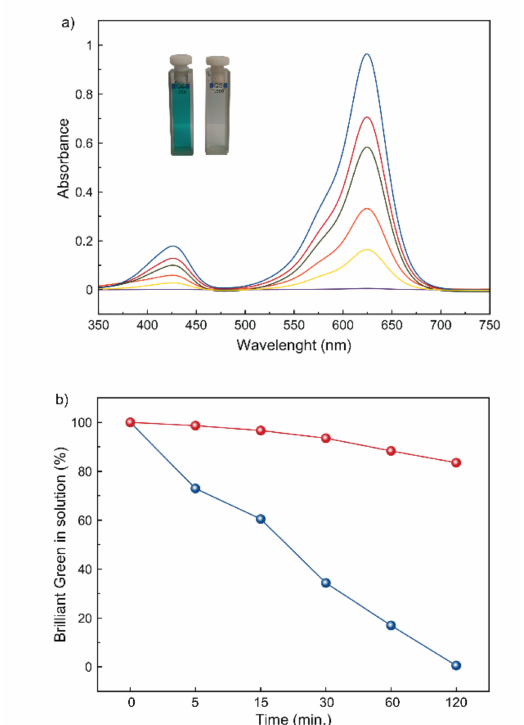
Figure 6. ( a ) Evolution with time of the UV-Vis absorption spectra of 10 ppm solutions of brilliant green in water in the presence of 25 mg of a polycrystalline sample of 1. Blue: t = 0; Red: t = 5 min.; Green: t = 15 min.; Orange = 30 min.; Yellow: t = 60 min.; Purple: t = 120 min. The inset shows the BG solutions at t = 0 min. (left) and 120 min. (right) of exposure of the BG solution with MOF 1. ( b ) Kinetic profile of the degradation of brilliant green under irradiation at 250 nm in the presence of MOF 1 (blue) and with no photocatalyst